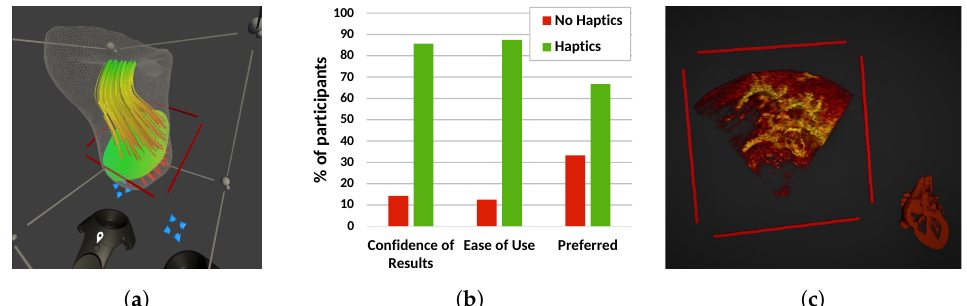
Figure 4. Experimental features investigated using our VR system. ( a ) Visualisation of a CFD blood flow simulation in the right ventricle of an HLHS patient, showing blood velocity with streamlines and a user-defined plane with the pressure distribution over that plane. ( b ) User opinion on using haptic feedback during a measurement task, showing overall preference for enabled haptics. ( c ) Automatic anatomical orientation of the rendered volume that is aligned with a cardiac